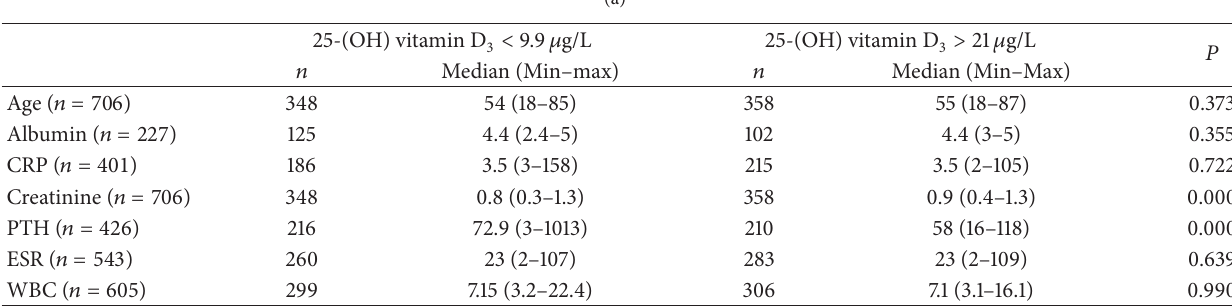
Table 4: (a) Vitamin D deficient and normal group medians in subjects without renal failure; (b) vitamin D 3 medians in subjects with renal failure.